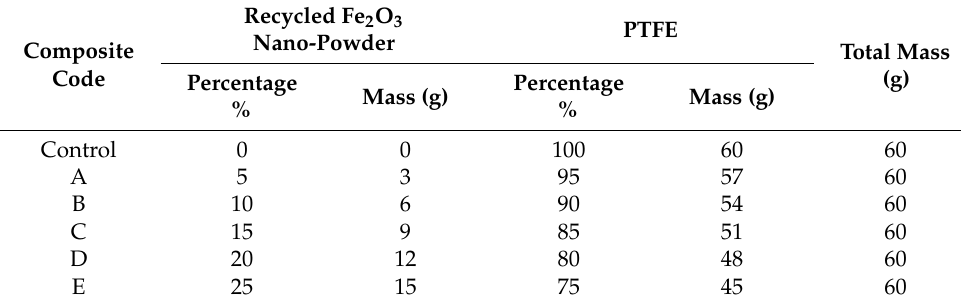
Table 1. Composition of rFe 2 O 3 –PTFE